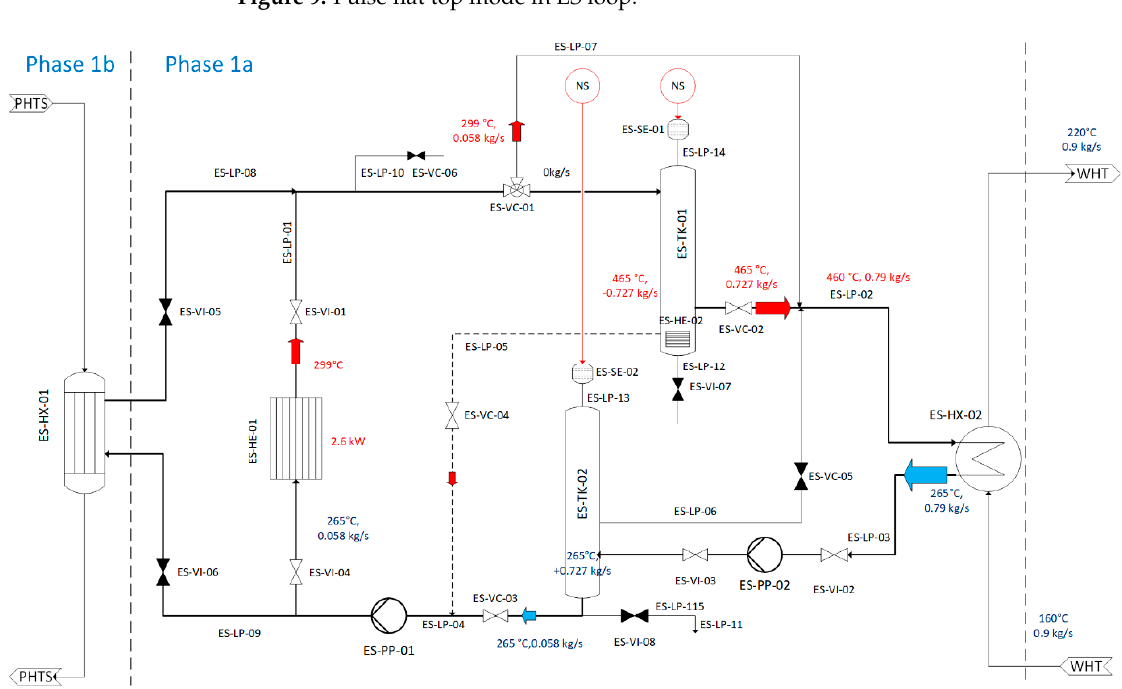
Figure 10. Dwell flat bottom mode in ES loop. Pulse flat top: ES-HE-01 simulates the heat source of the helium with 260 kW. The bypass ES-LP-05 with the valve ES-VC-04 regulates the precise demand on the MS inlet and outlet temperatures in ES-HE-01. Duration: about 7200 s. Dwell flat bottom: The ES-HE-01 power level is 2.6 kW and it is cooled by a small stream of MS from ES-TK-02. The bypass ES-LP-05 regulates the inlet and outlet MS temperatures through ES-HE-01. MS from the ES-HE-01 is directed to bypass ES-LP-07